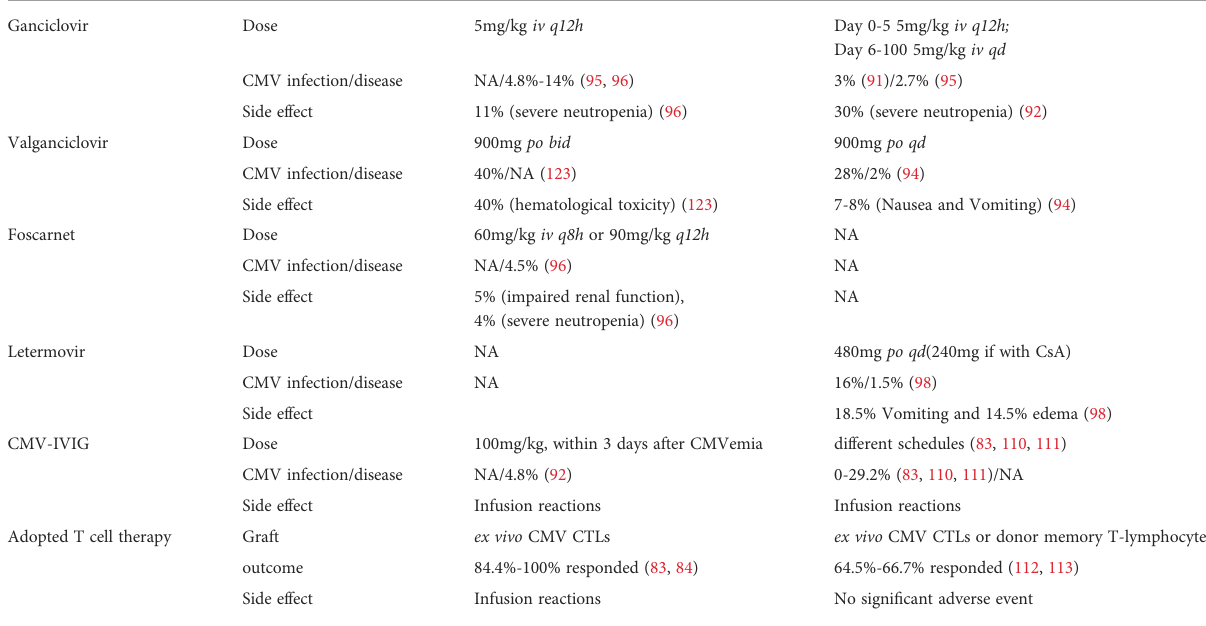
TABLE 3 Preemptive and prophylaxis treatment for CMV